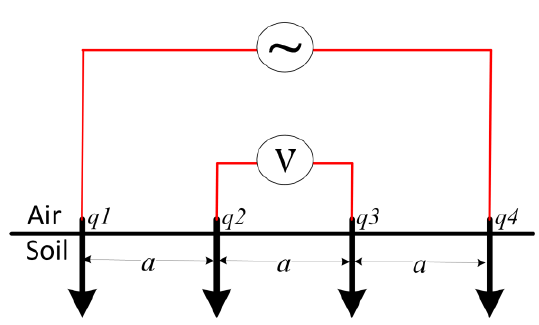
Fig. 1. Simplified disposition in soil of six different grounding